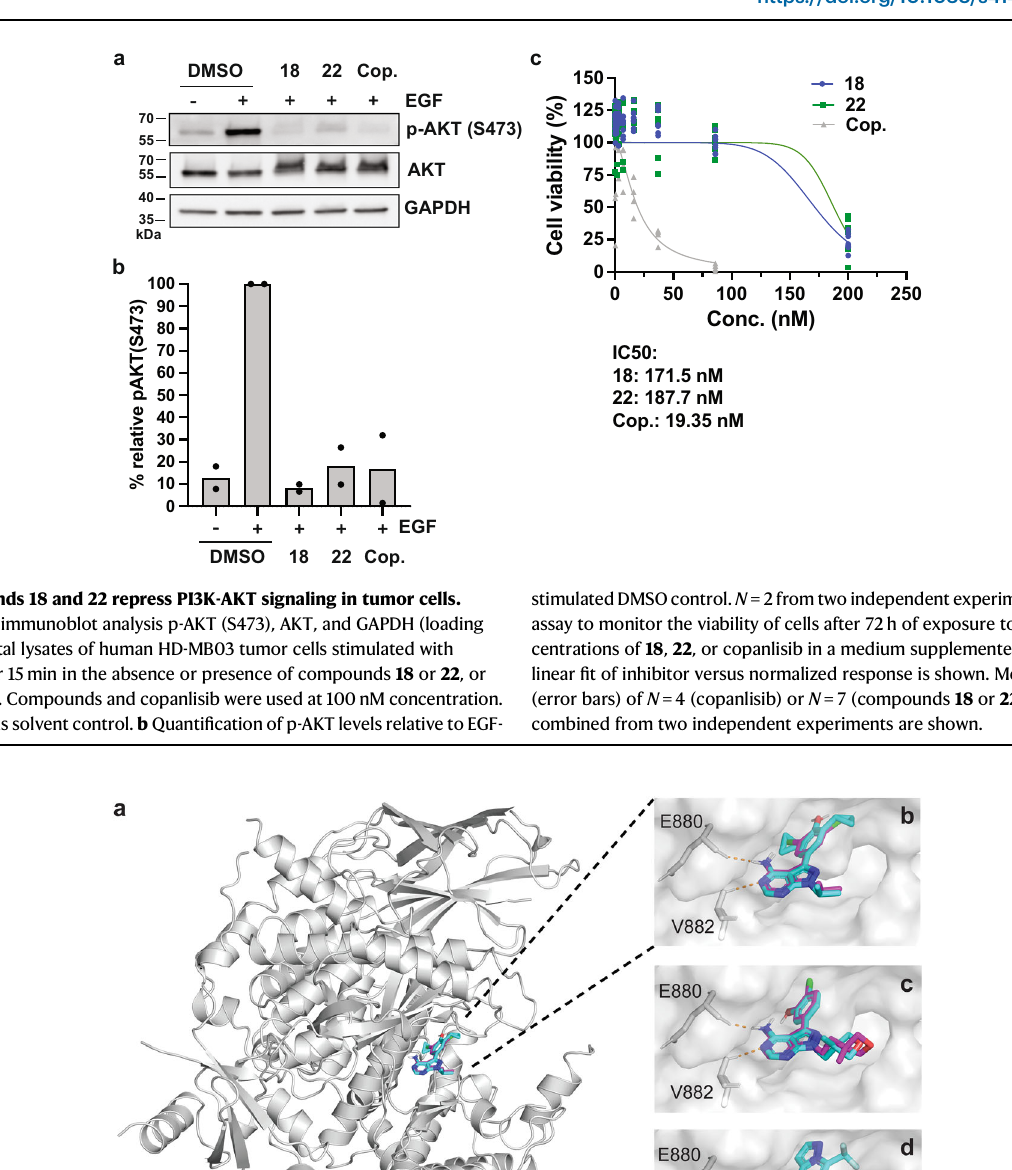
(blue) and 22 (magenta). c Close-up view of the binding poses of molecules 17 (magenta) and 18 (blue). d Close-up view of the computed binding pose of mole- cule 1 (in